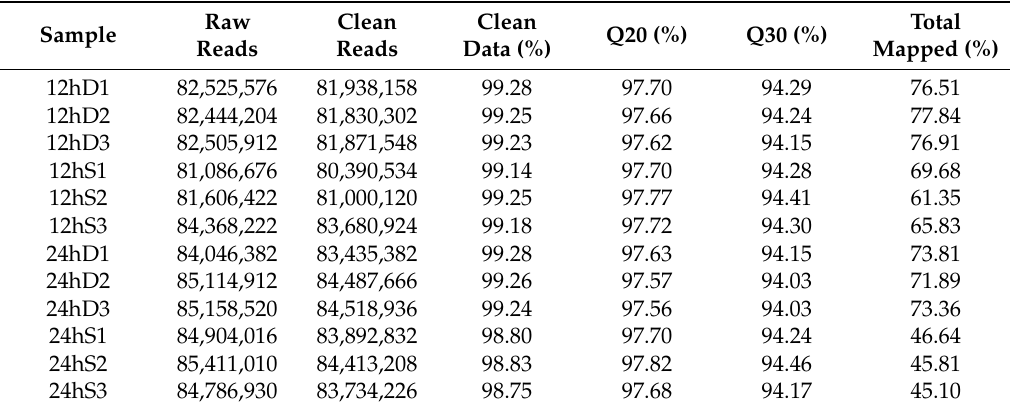
Table 1. Sequencing data generated by an Illumina HiSeqTM 2000 sequencer.